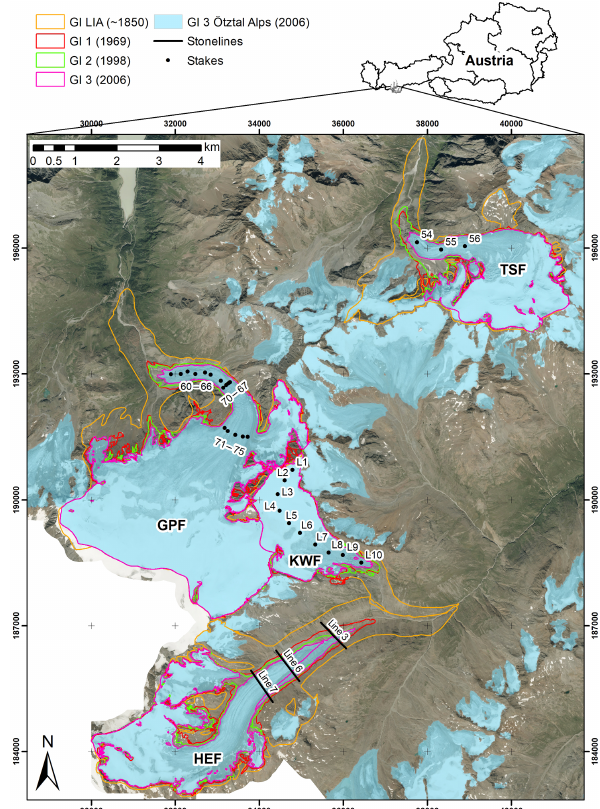
Figure 1. Location of the stone lines (3, 6 and 7) on Hintereisferner (HEF) and stakes on Kesselwandferner (KWF), Taschachferner (TSF) and Gepatschferner (GPF). On Gepatschferner, stakes 60 to 66 are longitudinal stakes from the glacier snout upwards to the first cross-profile including the stakes 67 to 70 (from the orographic right to the left). Stakes 71 to 75 are located in a cross-profile at the root zone of the tongue. The glacier area was taken from the Aus- trian Glacier Inventories (GI) from the LIA (Little Ice Age) around 1850, GI1 from 1969, GI2 from 1998 and GI3 from 2006 (Fischer et al., 2015). Background: orthophoto from 2015; data source: Land Tirol –